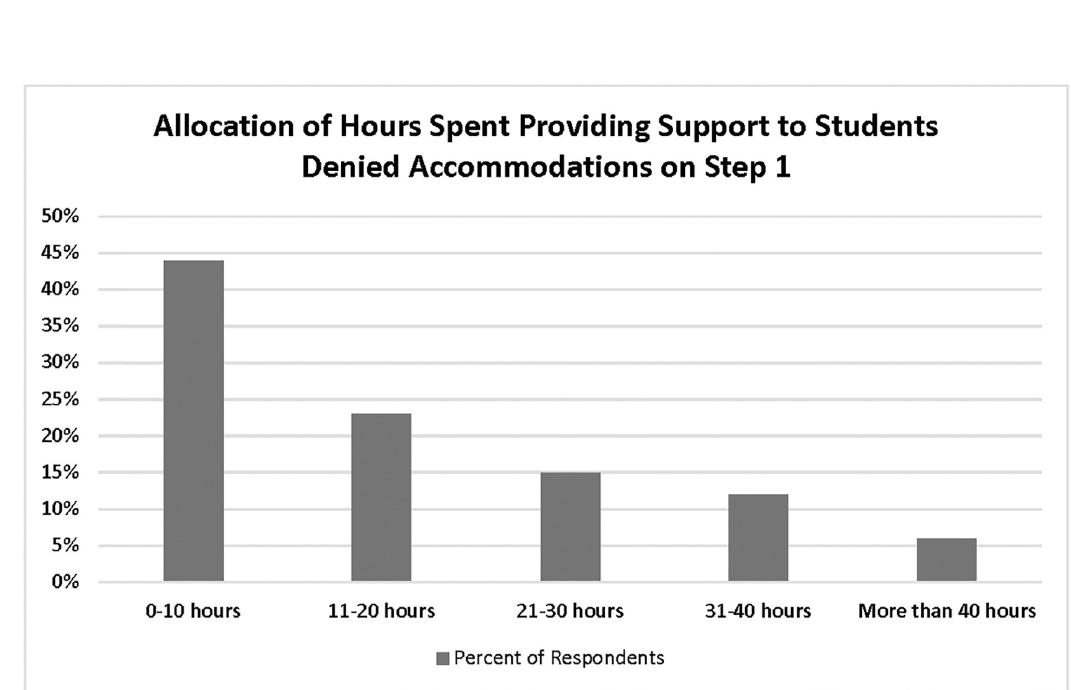
Fig 2. Allocation of hours spent providing support to students denied accommodation on Step 1 examination [N = 73).